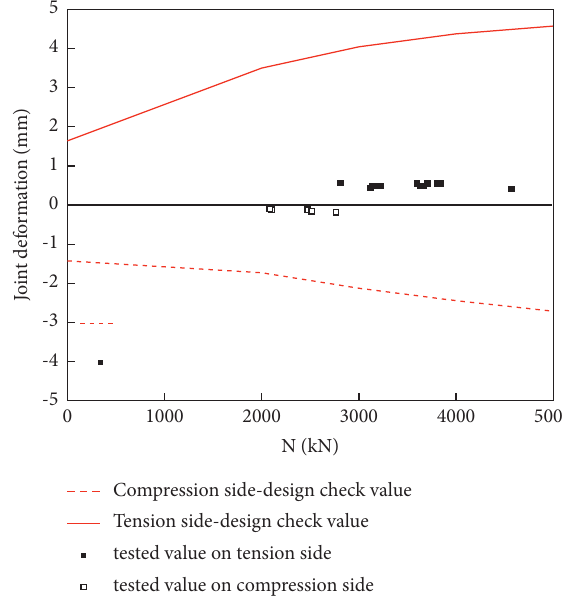
Figure 20: Deformation envelope of joint